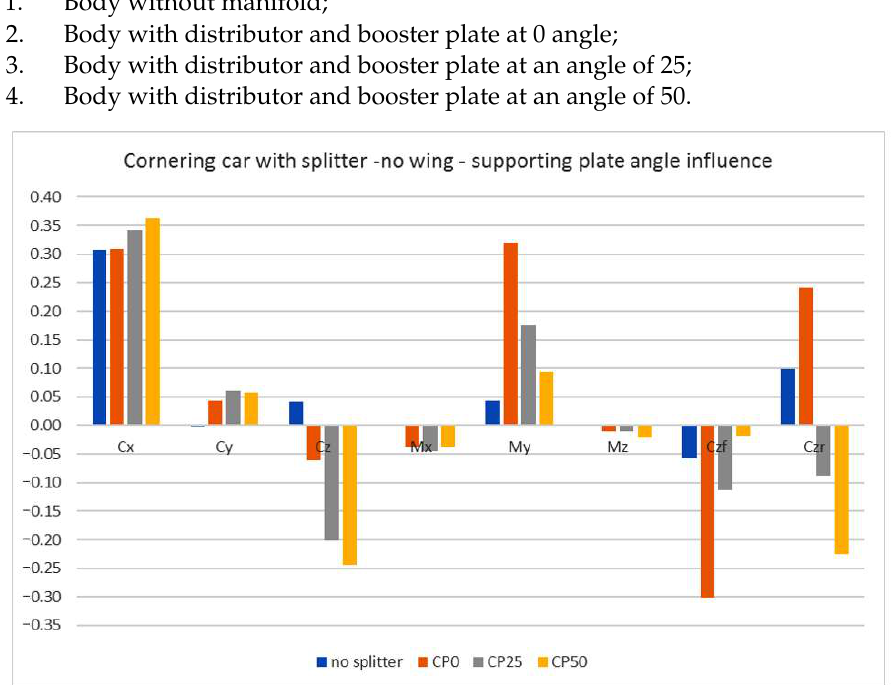
Figure 25. Comparison of aerodynamic coefficient values caused by the addition of the splitter and the change of booster plate angles during the 90 m radius curve. (no splitter and no supporting plate, CP0 with splitter and supporting plate at 0 deg, CP25 with splitter and supporting plate at 25 deg, CP50 with splitter and supporting plate at 50 deg).